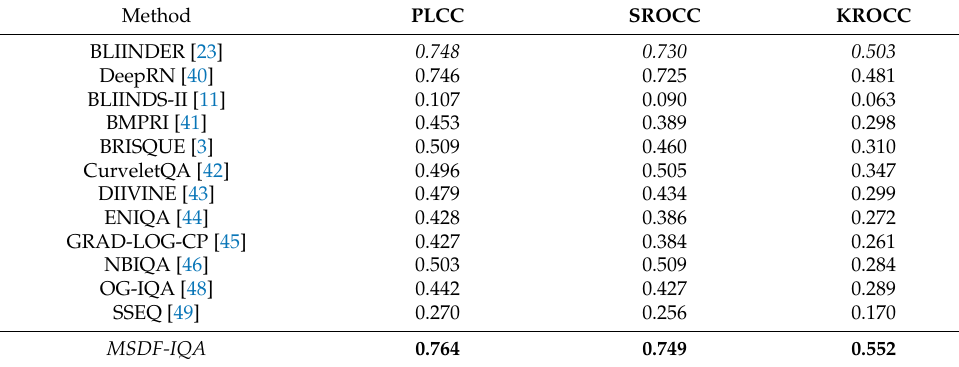
Table 11. Cross database test. Methods were trained on KonIQ-10k [1] and tested on CLIVE [34]. The best results are typed in bold , and the second best ones typed in italic .